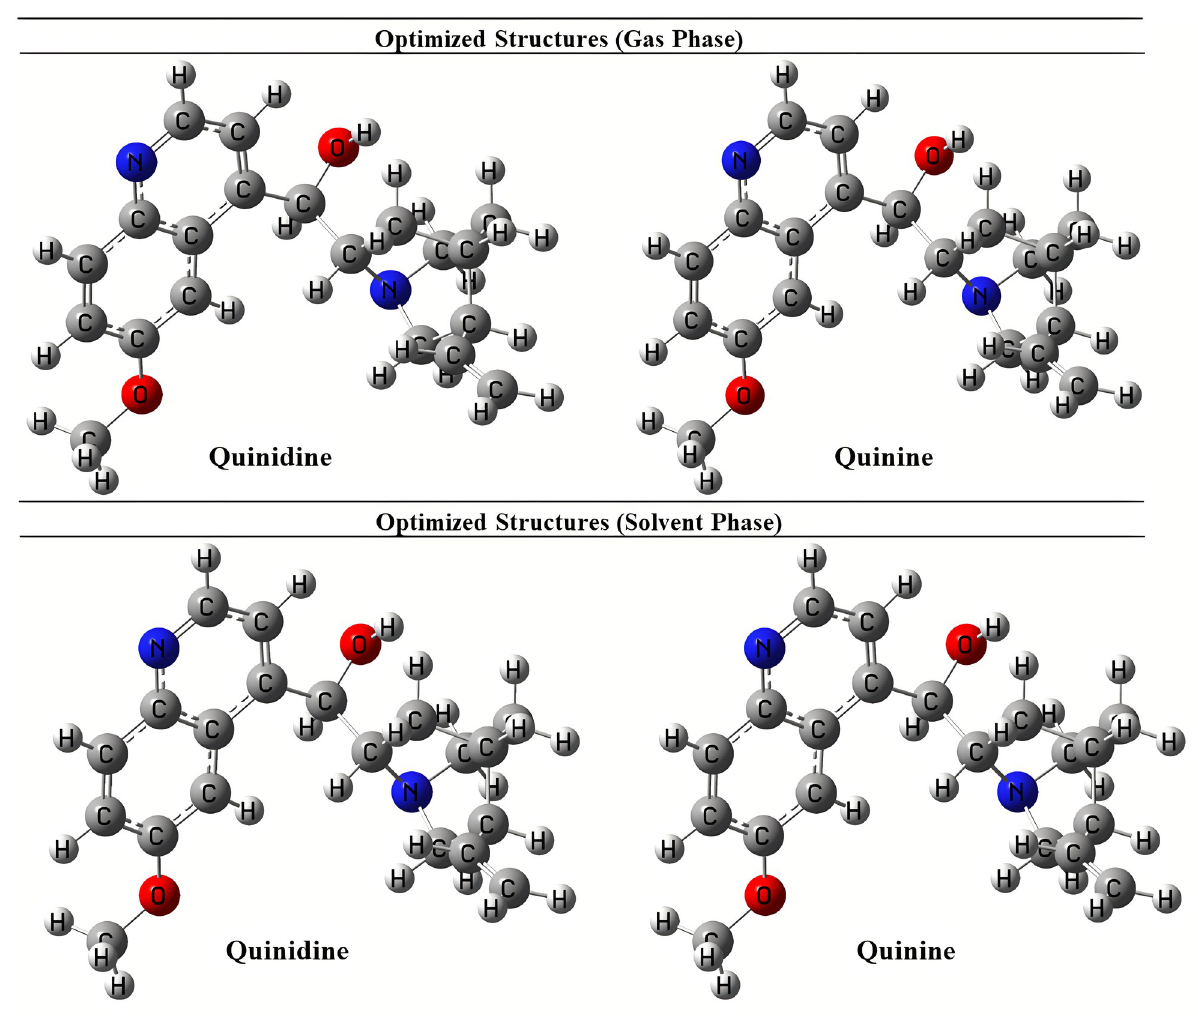
Fig 1. Optimized structures of quinolone derivatives.